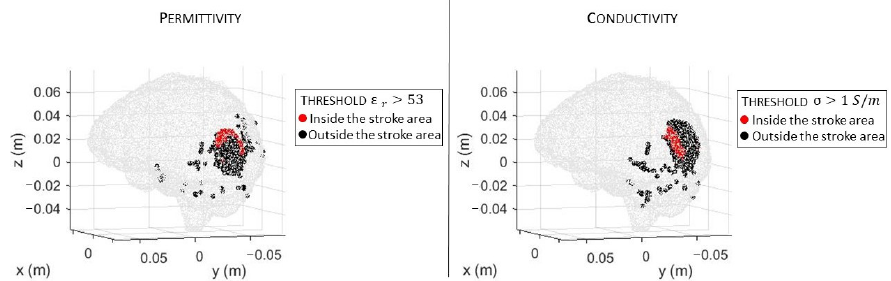
Figure 10. CSI algorithm results with the proposed discretization, considering half-brain DoI. The spots corresponds to the volume of the stroke identified by the algorithm after 100 iterations: on the left, permittivity, and on the right, conductivity. Red inside and black outside the stroke